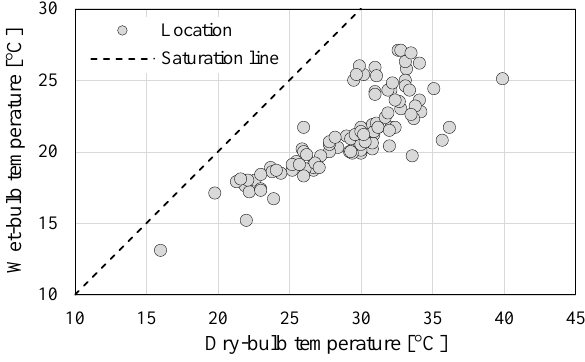
Figure 6. Nominal (design) outdoor air